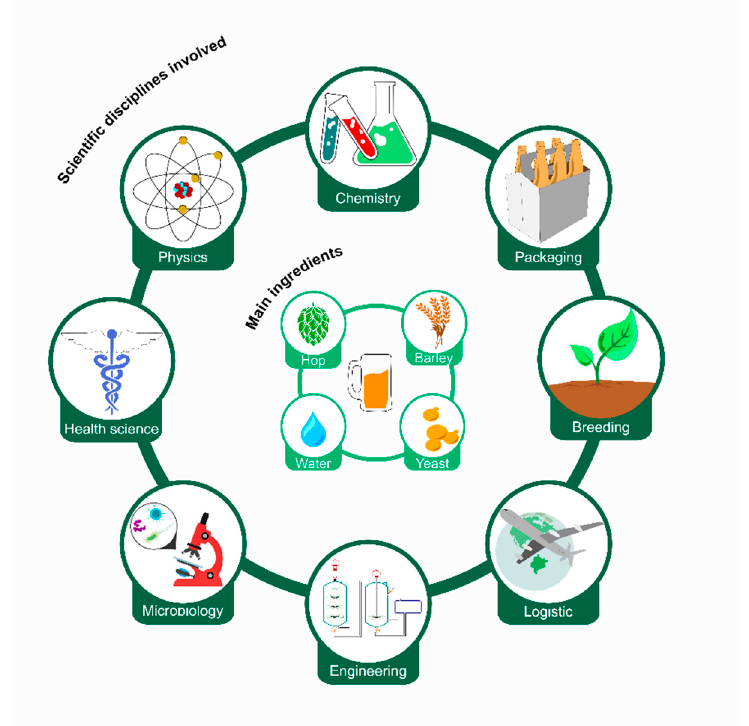
Figure 1. Multi-disciplinary perspective for challenging the brewing complexity. Basic ingredients required in the brewing process are summarized in the middle, while a plethora of disciplines involved in brewing science are depicted on the outside.